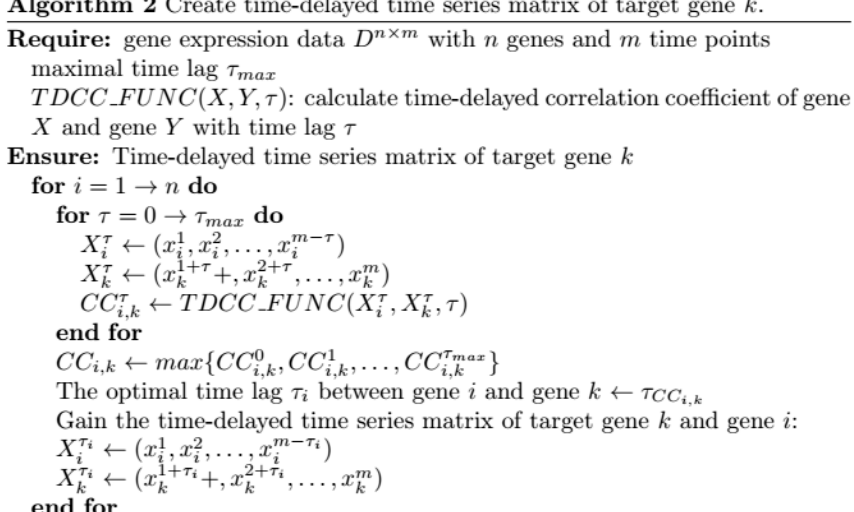
Figure 19. The pseudo code of creating time-delayed time series matrix of target gene k .